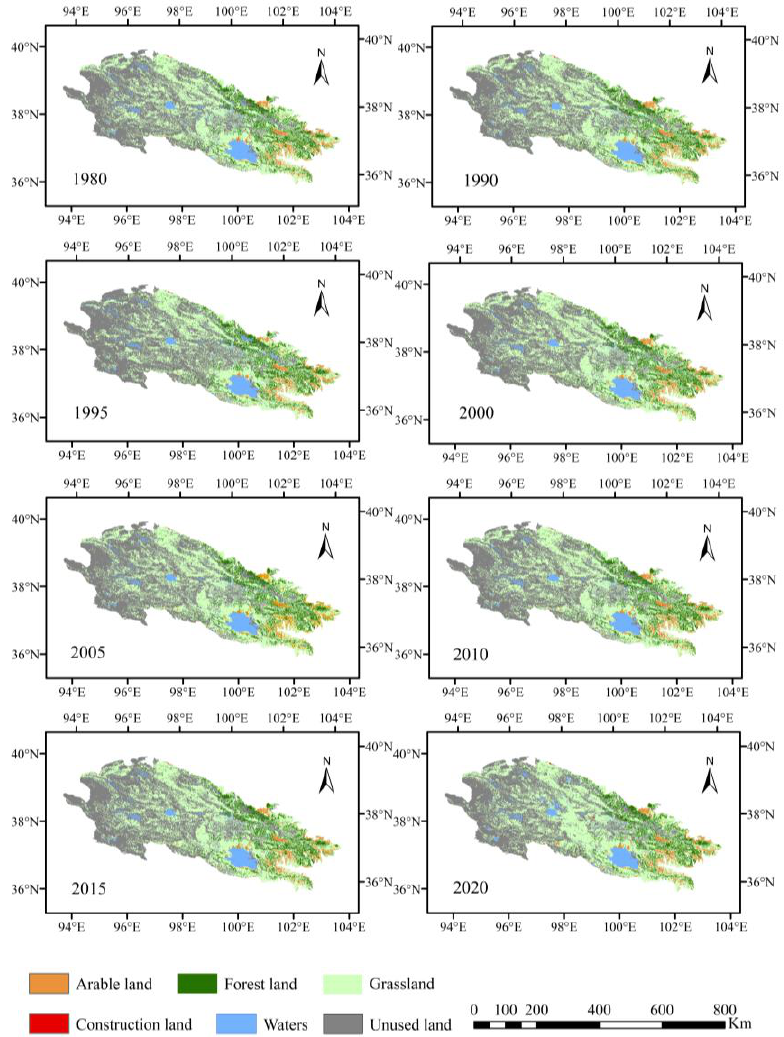
Figure 2. Spatial pattern of land use in the Qilian Mountains.